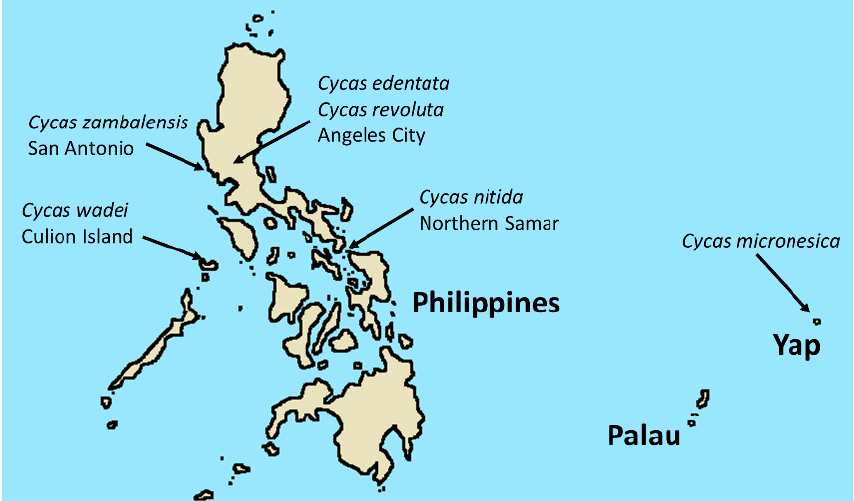
Figure 4. Map of the study locations in western Pacific islands.